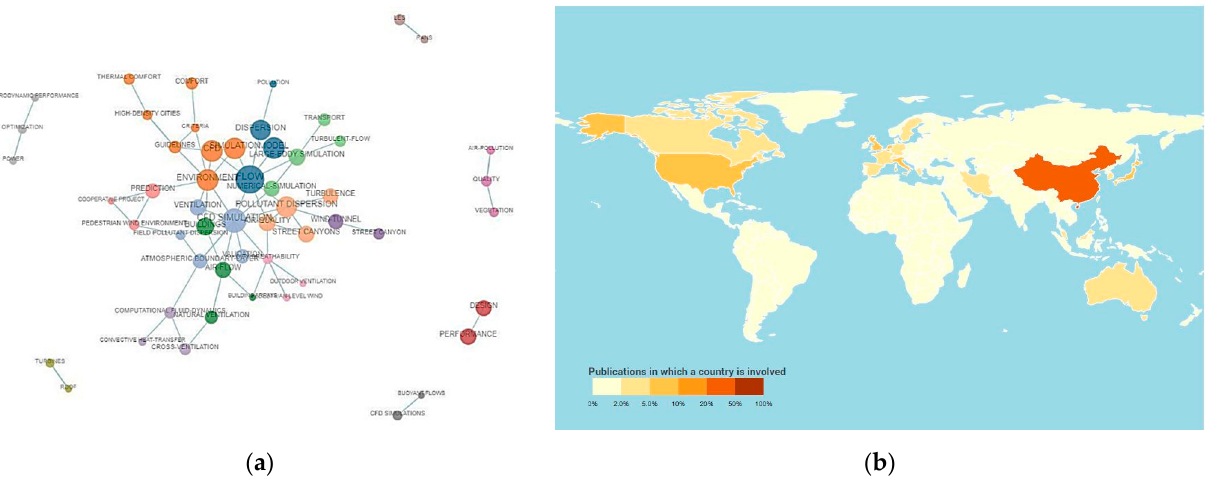
Figure 2. ( a ) Term map, ( b ) contribution of each country to the total number of papers.